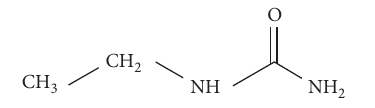
Figure 5: Molecular structural formula of polyurethane.